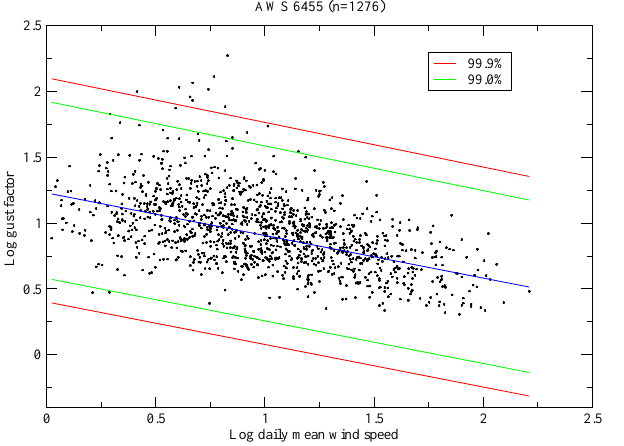
Figure 4. Log daily peak-gust factor plotted against daily mean wind speed, for an arbitrary sample of n = 1276 consecutive days (AWS 6455), with regression (blue line) and resistant prediction bounds (99% in green and 99.9% in red,